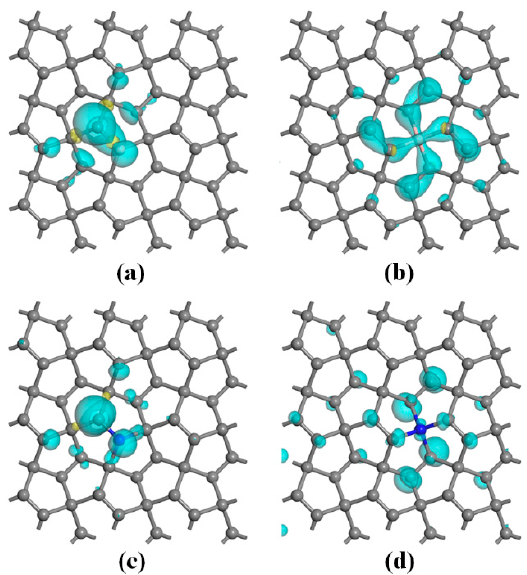
Figure 6. Spin distributions of ( a ) PG–B (sp 2 ), ( b ) PG–B (sp 3 ), ( c ) PG–N (sp 2 ) and ( d ) PG–N (sp 3 ) with the isovalues of ± 0.02 a.u. The poor blue and yellow represent positive and negative spin densities, respectively.